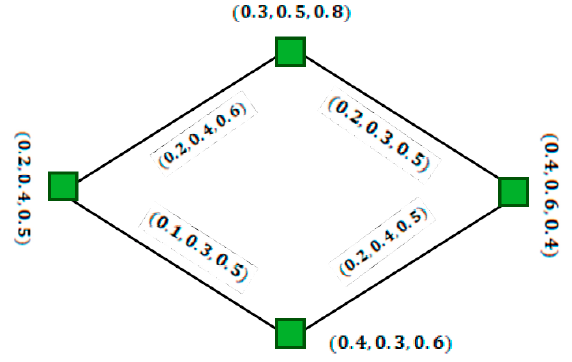
Figure 18. Single-valued neutrosophic graph.